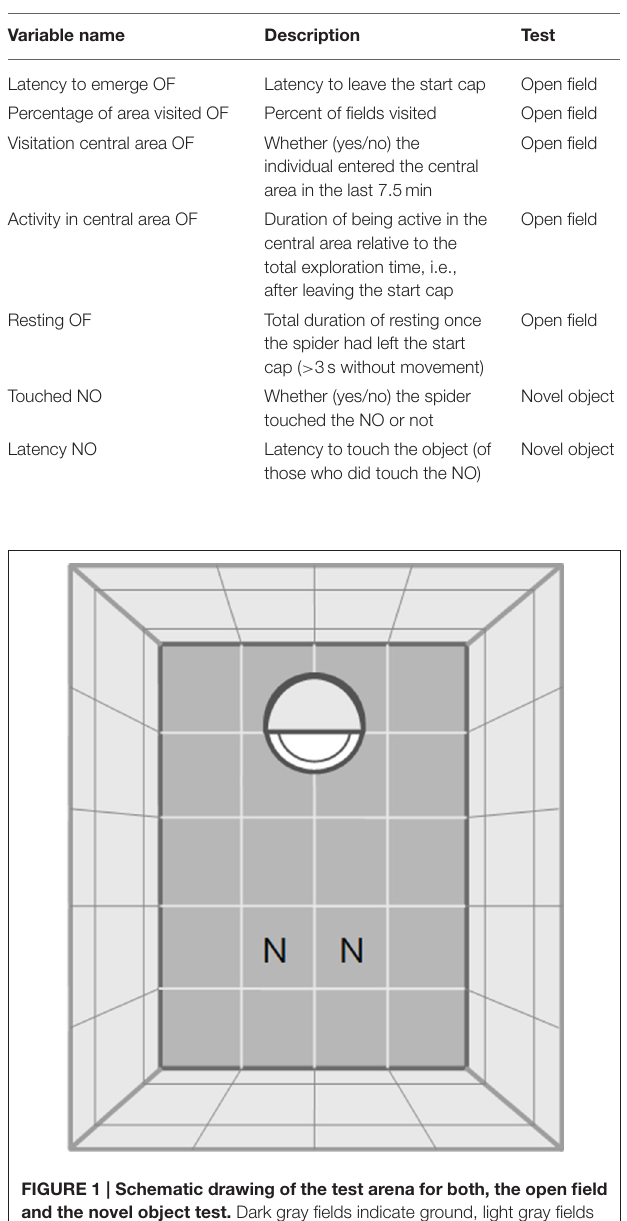
TABLE 2 | Variables recorded from the open field (OF) and novel object (NO) test as measures of exploratory behavior.